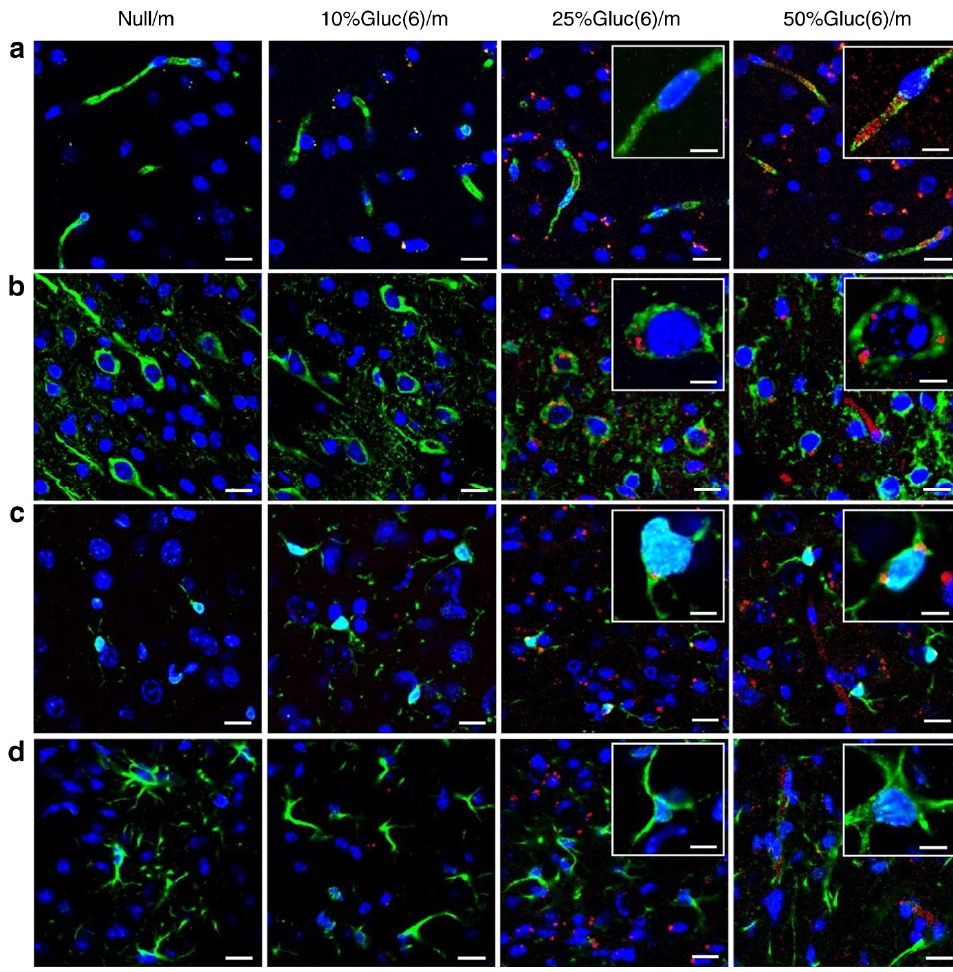
Figure 5. Interaction between C6-position glucose-functionalized polymeric micelles containing different glucose densities and the mouse brain. Sections were immunolabelled with ( a ) anti-PECAM1 antibody for brain capillary endothelial cells, ( b ) anti-Tuj1 antibody for neurons, ( c ) anti-Iba1 antibody for microglia, and ( d ) anti-GFAP antibody for astrocytes (green); DAPI (blue) for nuclei and micelles are labelled with fluorescent dye Cy5 (red). Scale bar: 20 µm (10 µm in insets). Adapted with permission from Reference [12], Springer Nature, 2017.